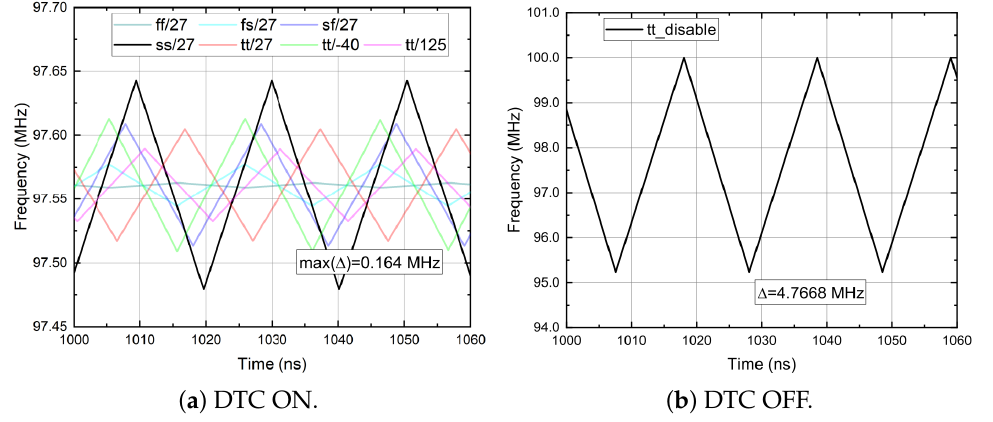
Figure 10. Output frequency of fractional